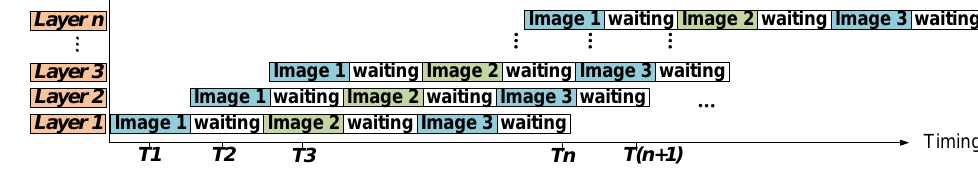
Figure 1. Timing graph of the pipelined